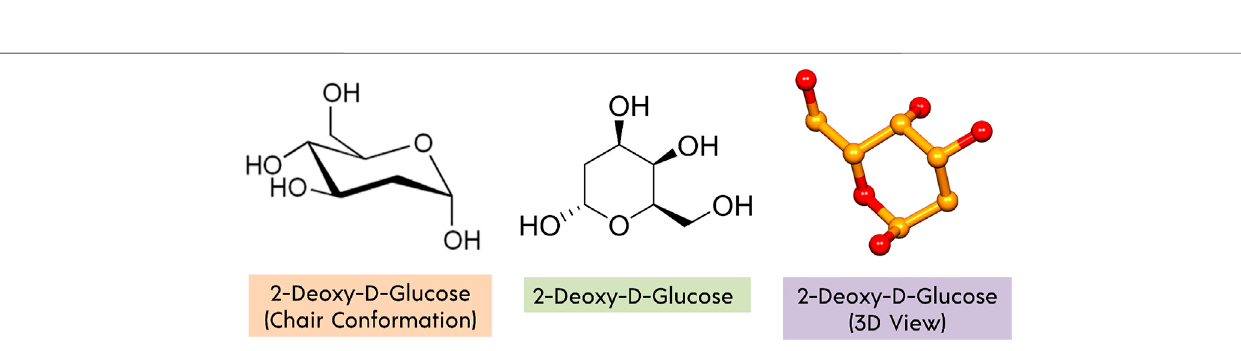
FIGURE 3 | The structure of